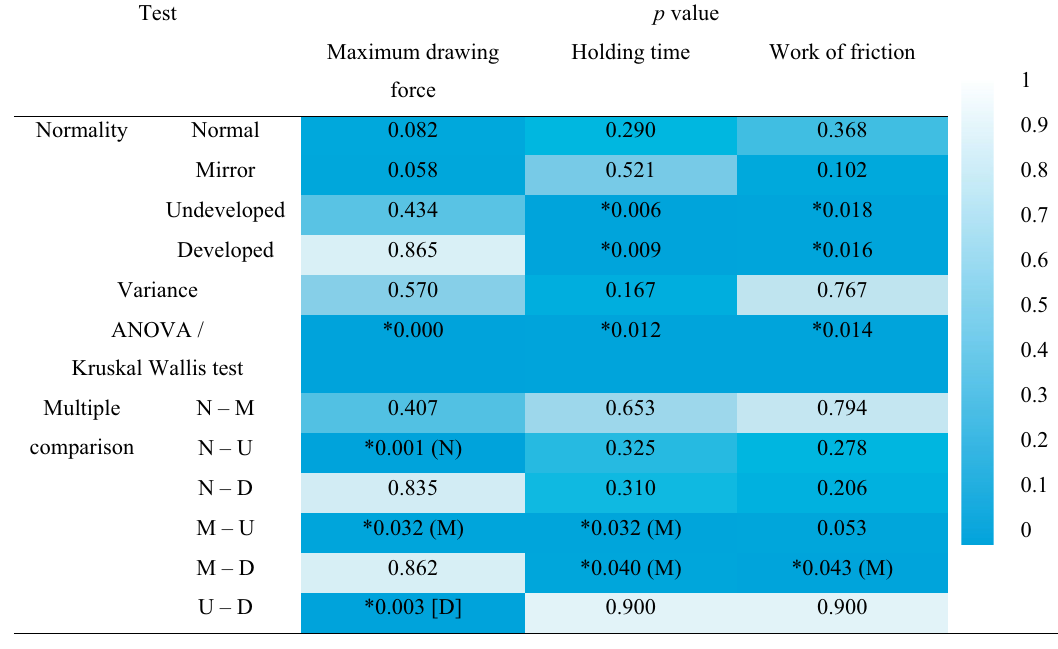
Table 1. p value for each test. Asterisk (*) indicates p < 0.05. In the results with multiple comparisons, () indicates that asymmetry group is superior and [] indicates that there is a difference within the group, and superior pair is in